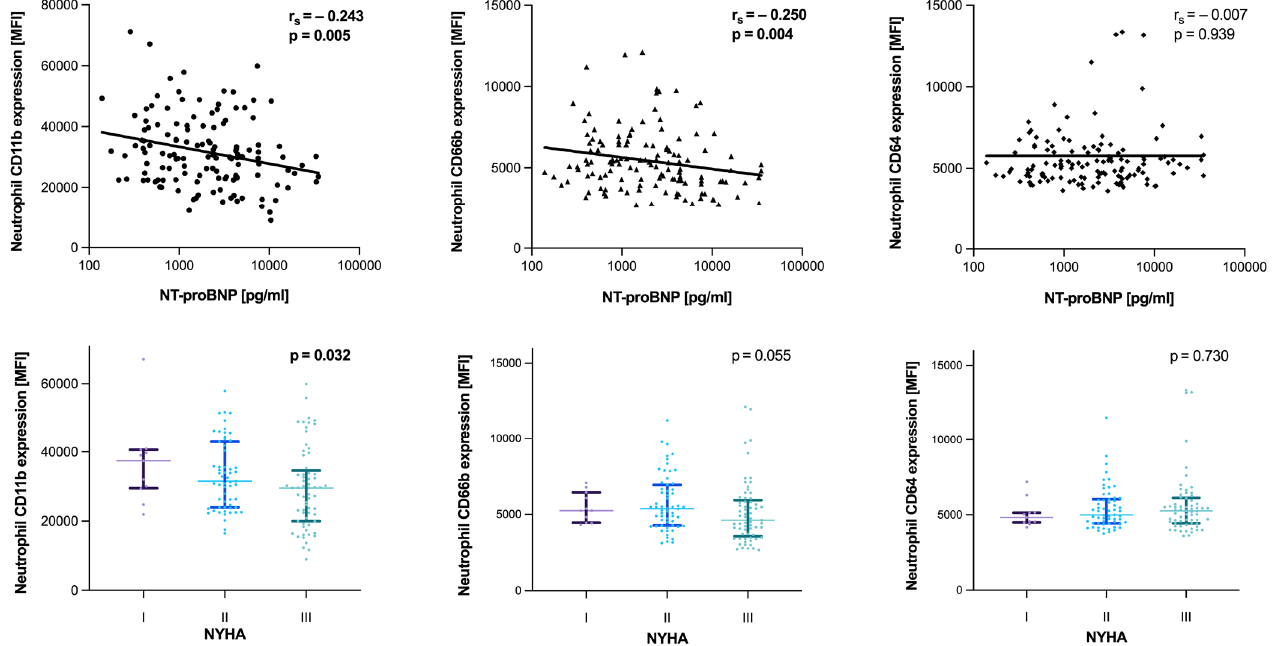
Figure 2. Relationship of neutrophil activation/maturation markers and heart failure severity. Scatter plots with linear regression analysis and the Spearman’s rho correlation coefficient for mean fluorescence intensities (MFI) of neutrophil CD11b, CD66b and CD64 expression with N-terminal pro B-type natriuretic peptide (NT-proBNP), as well as group comparisons between New York Heart Association (NYHA) class, are shown. Comparison between groups has been assessed by using the Kruskal–Wallis test, level of significance is indicated in the respective plots.